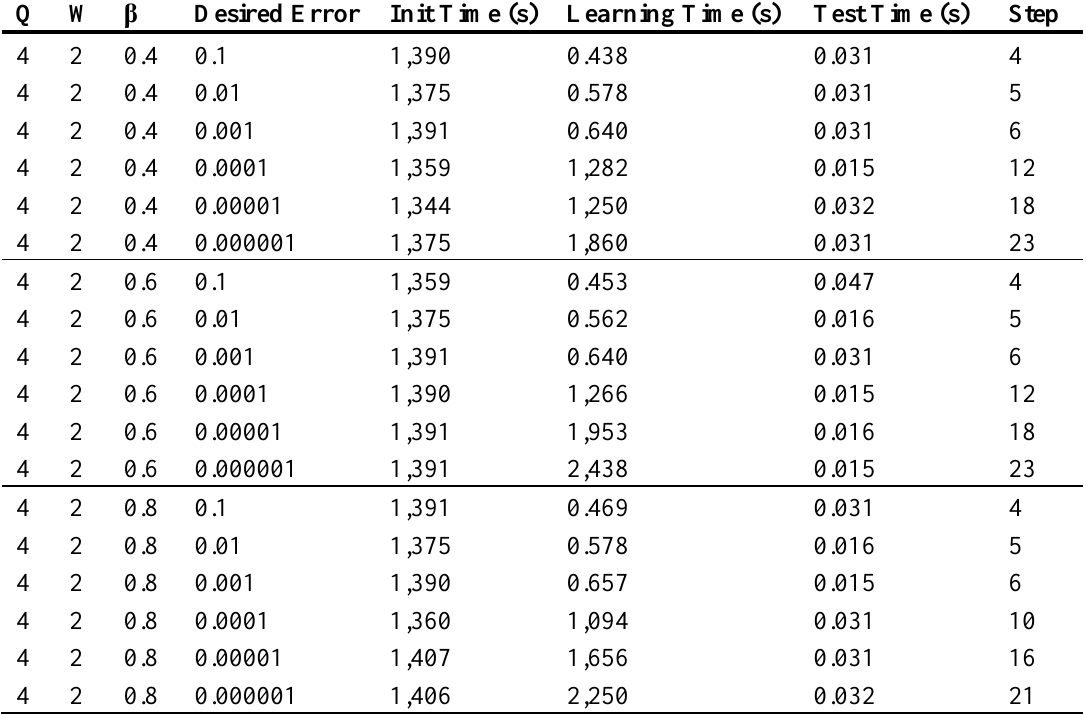
Table 1. Results of the CMAC Neural Network Algorithm for the odor